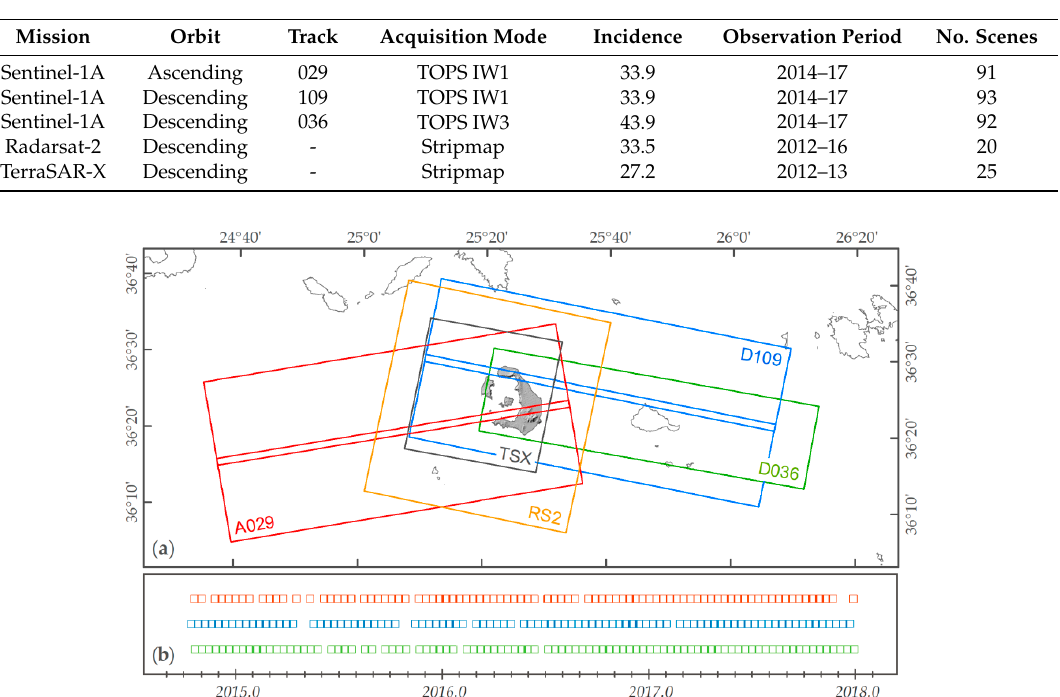
Table 2. Interferometric pairs considered in Sentinel-1 MT-InSAR processing.